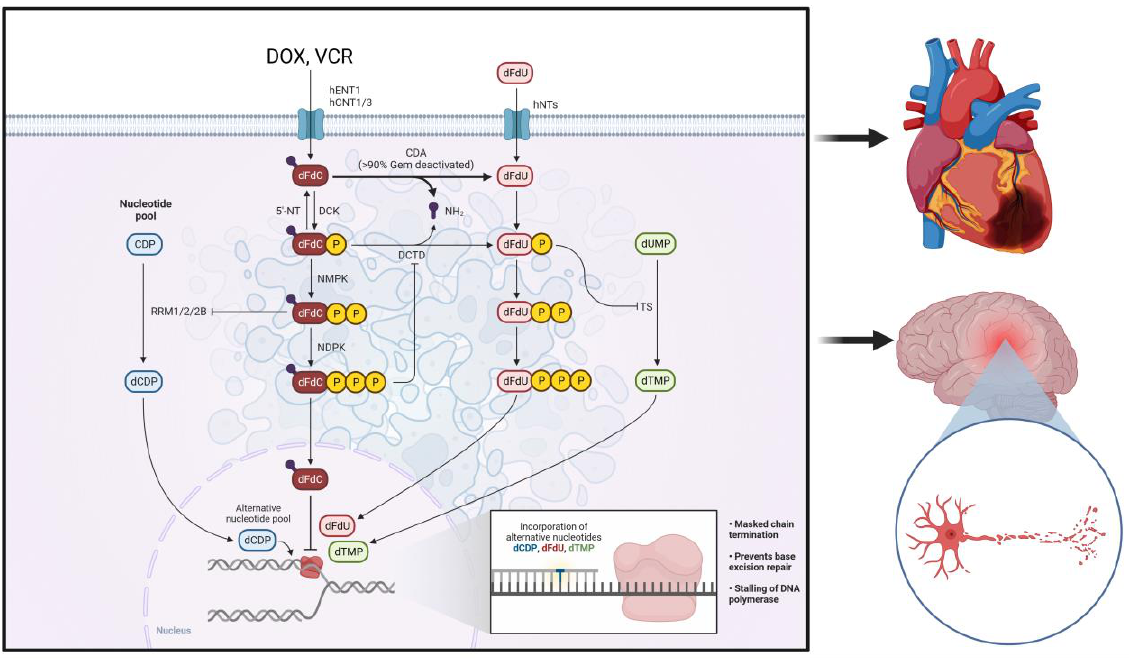
Figure 1. Neuropathy and myopathy induced by two commonly used chemotherapeutic agents (DOX and VCR) in pediatric cancer treatment. DOX, an anthracycline drug to treat solid tumors in children, such as Wilm’s tumor, was approved by the FDA in 1974 to become the first clinical liposomal encapsulated anticancer drug [29]. DOX acts as an intercalation that inhibits topoisomerase II and further obstructs DNA replication [30]. The recommended dosage (2 mg/mL) is the same in both pediatric and adult patients. Symptoms of the side effects may include abnormality in electrocardiography, rhythm disturbances, and even left ventricular hypertrophy that leads to a reduction in ejection fraction